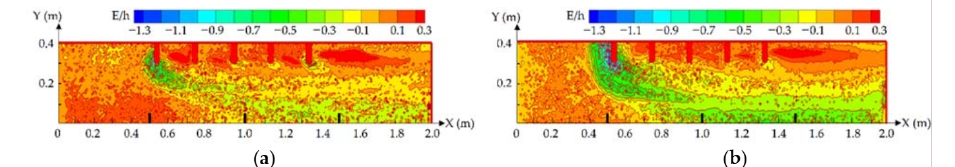
Figure 13. Overview of the measured non-dimensional bed changes around multiple spur dikes: ( a ) case G4a and ( b ) case G5a. E is the scour depth, and h is the average water depth.